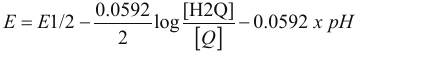
Figure 6. Voltammograms of WO values ranging from 2 to 12 with magnification to guide the eyes.